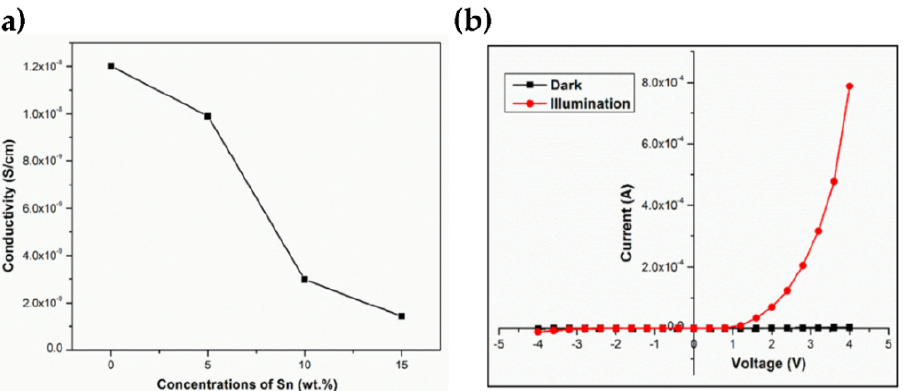
Figure 15. ( a ) The average conductivity of 0, 5, 10, and 15 wt.% of Sn 0.26 WO 3 thin films ( b ) I–V char- acteristics of 15 wt.% of the n − Sn 0.26 WO 3 /p − Si diode in darkness and under light illumination. Re- characteristics of 15 wt.% of the n-Sn 0.26 WO 3 /p-Si diode in darkness and under light illumination. produced or adapted from [84]. Reproduced or adapted from